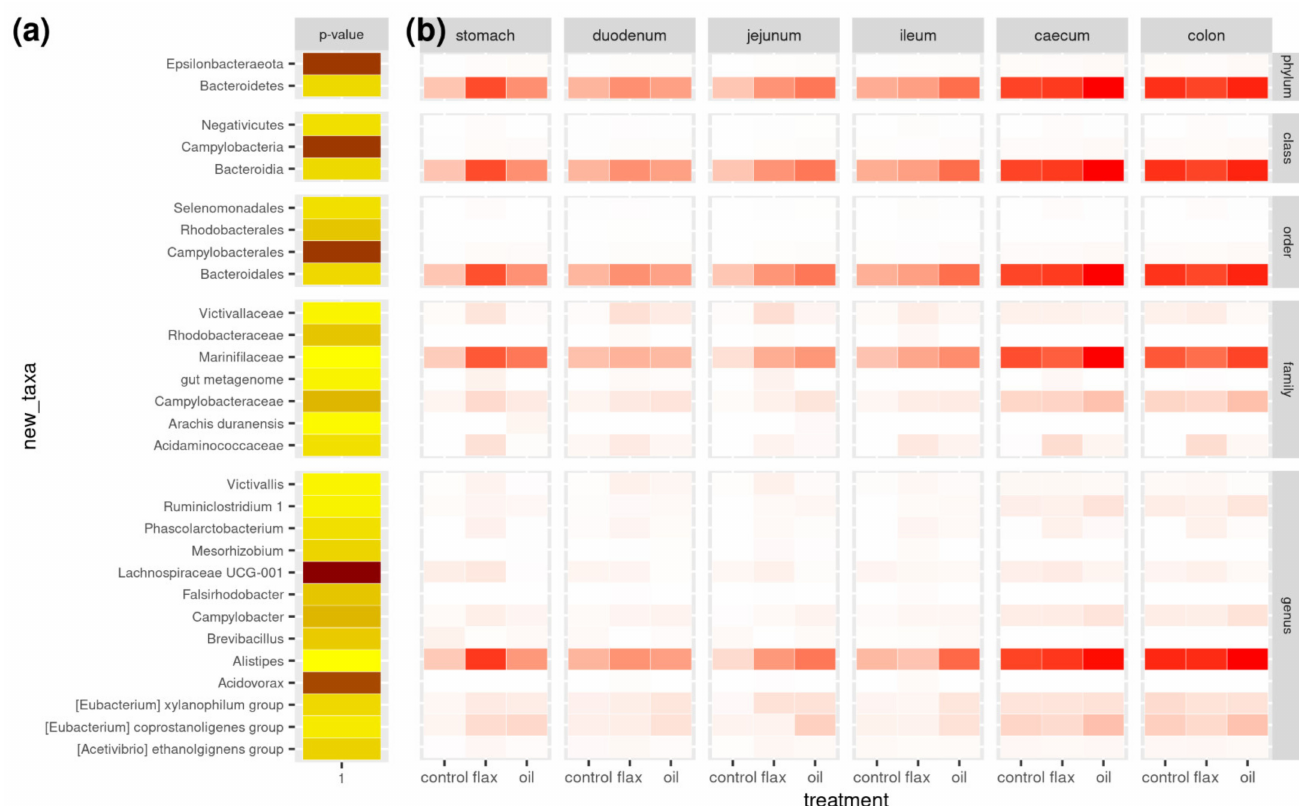
Figure 3. Heatmap of significance and abundance of significantly different taxa. In ( a ), the -log( p -value) for the difference between treatments along the gastrointestinal tract is reported ( p -values are in the range 10–15–0.049, from dark brown to light yellow). In ( b ), the relative abun- dances of each significant OTUs in the consecutive sections of the gastrointestinal tract of rabbits are shown (darker colors indicate higher abundance). OTUs are grouped per taxonomic level (from phylum to genus). Groups ( n = 5/group): control and enriched diets supplemented with flaxseed (flax) and fish oil (oil). p -values were obtained from a linear model that included the effects of treatment and tissue within